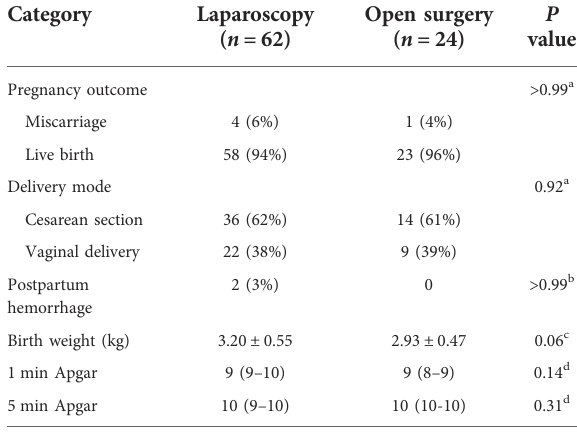
TABLE 3 Obstetric outcomes in laparoscopy and open surgery groups.